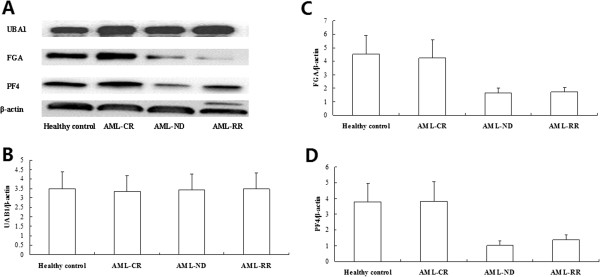
Validation of protein fragment by immunoblotting. (A) Levels of the UBA1 protein did not differ among the leukemia and normal cells. Isoform 1 of fibrinogen alpha chain precursor and PF4 immunoreactive bands show that weak or no bands are seen in newly diagnosed and refractory & relapsed AML cases. (B) Densitometry comparison of UBA1 protein relative to β-actin as determined by western blot analysis in figure A. (C) Densitometry comparison of isoform 1 of fibrinogen alpha chain precursor protein relative to β-actin as determined by western blot analysis in figure A. (D) Densitometry comparison of PF4 protein relative to β-actin as determined by western blot analysis in figure A. (UBA1: ubiquitin-like modifier activating enzyme 1; FGA: isoform 1 of fibrinogen alpha chain precursor; PF4: platelet factor 4; AML-CR: AML complete remission; AML-ND: AML newly diagnosed; AML-RR: AML refractory & relapsed).